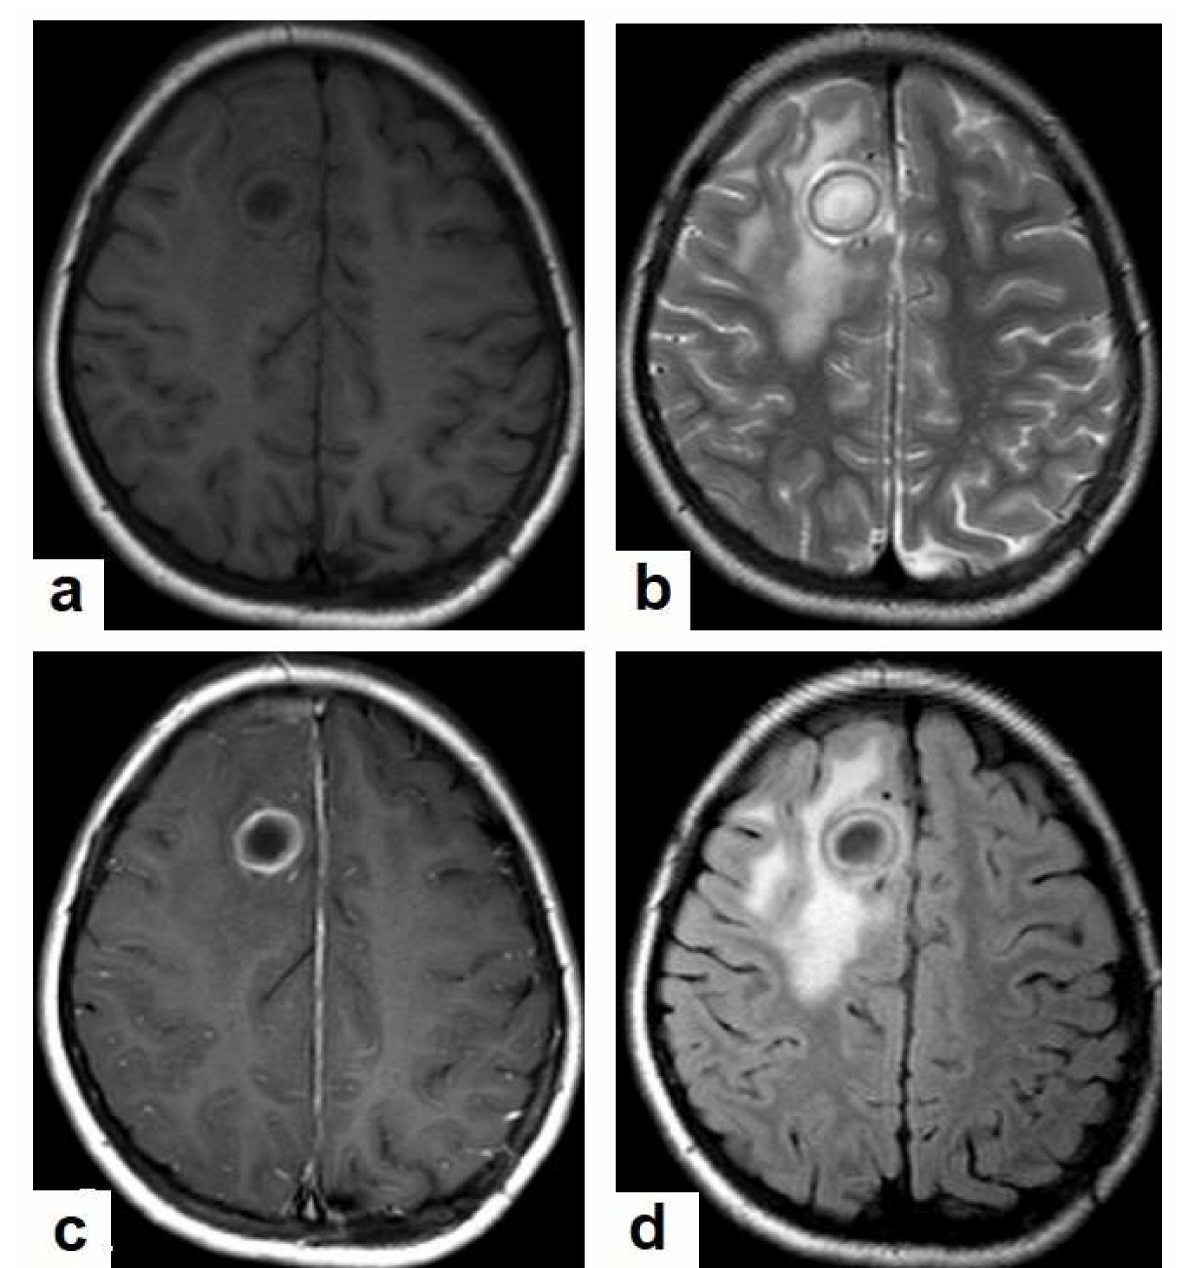
Figure 16. Tuberculous abscess in the right cerebrum of a 13-year-old female. Selected images of brain MRI ( a ) T1-weighted image (WI), ( b ) T2-WIs, ( c ) T1-WI with contrast, and ( d ) FLAIR-WI. The images show a well-defined lesion in the right cerebral hemisphere with low-signal-intensity content and a high-signal-intensity capsule on T1WI, which appear as high-signal-intensity content and a low-signal-intensity capsule on T2WI ( b ); there is marginal enhancement on T1WI with contrast administration ( c ), and there are low-signal-intensity contents and a high-signal-intensity capsule on FLAIR ( d ). Obvious grade-2 vasogenic oedema around the lesion on T2WI and